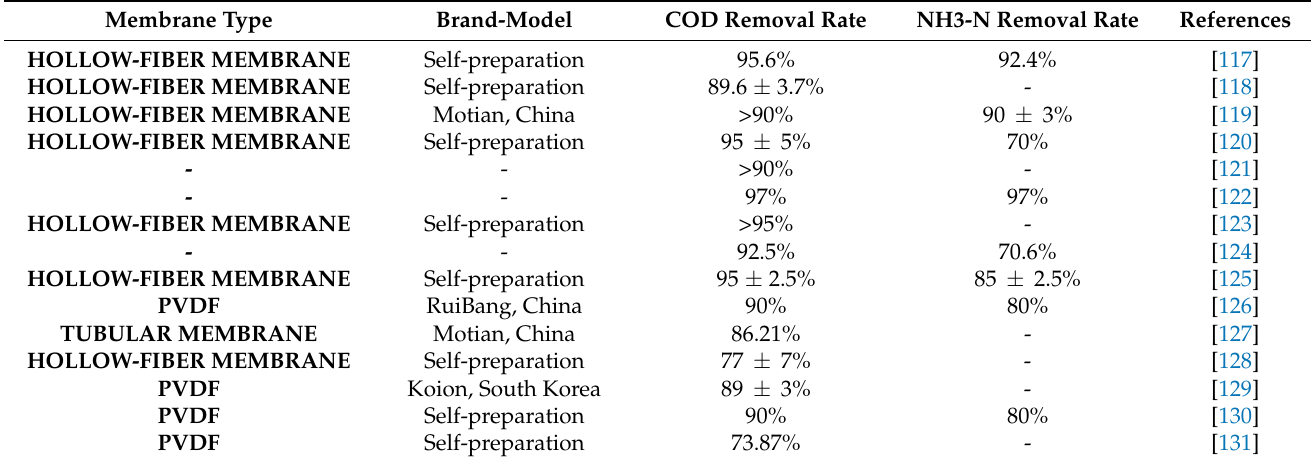
Table 5. MFC-MBR coupling systems for wastewater